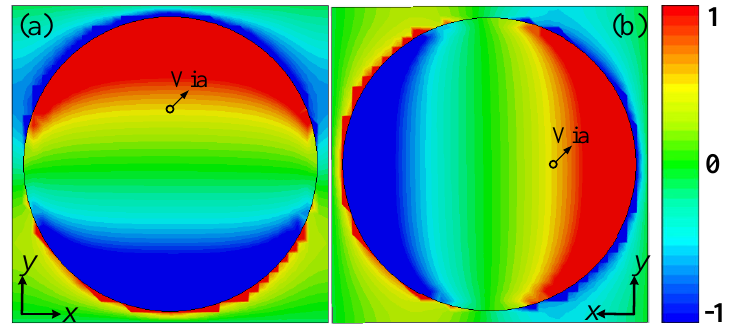
Figure 3. The simulated distributions of the electric field component perpendicular to the unit cell (i.e., E z ): ( a ) Top layer. ( b ) Bottom